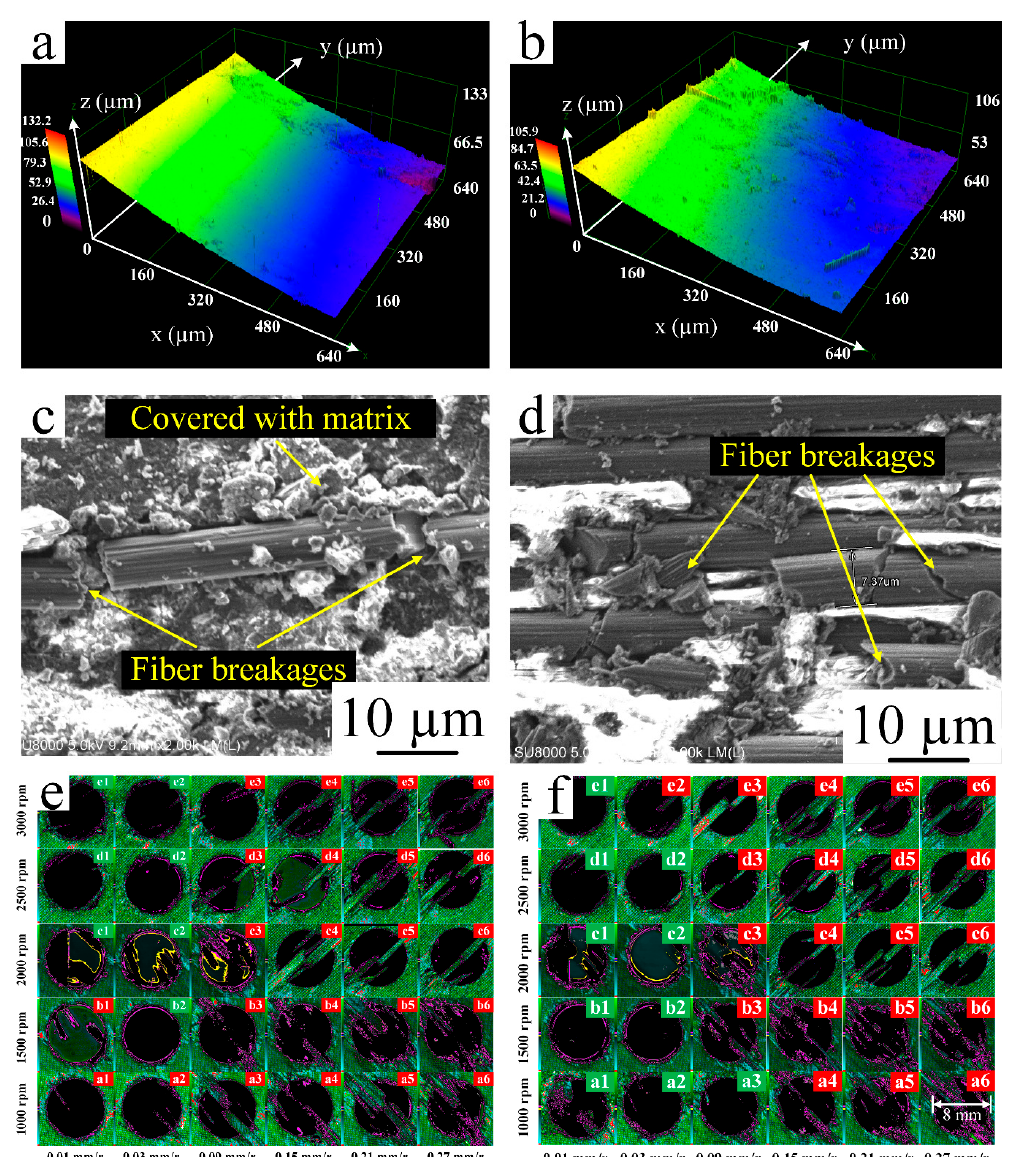
Figure 5. ( a ) Surface roughness of the hole drilled without cryogenic treatment; ( b ) surface roughness of the hole drilled with cryogenic treatment; ( c ) microstructure of the hole drilled without cryogenic treatment; ( d ) microstructure of the hole drilled with cryogenic treatment; ( e ) burr damage at the hole exit without cryogenic treatment; and ( f ) burr damage at the hole exit with cryogenic